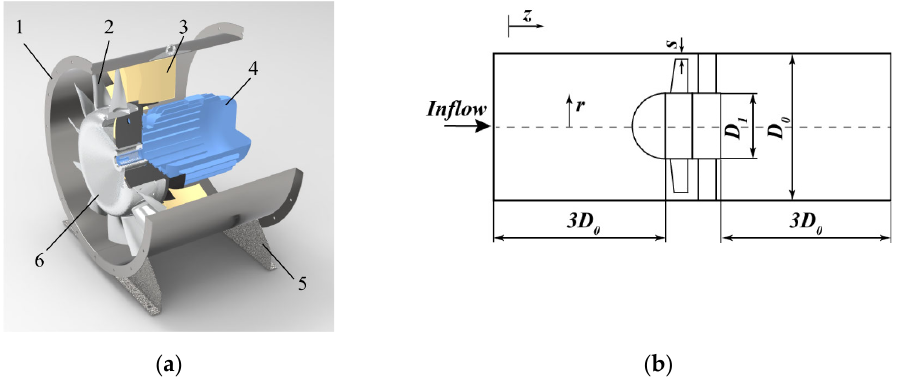
Figure 1. Schematic diagram of the prototype fan: ( a ) 3D model of the prototype fan; ( b ) schematic diagram of the pipeline system. Table 1. Main parameters of the original axial